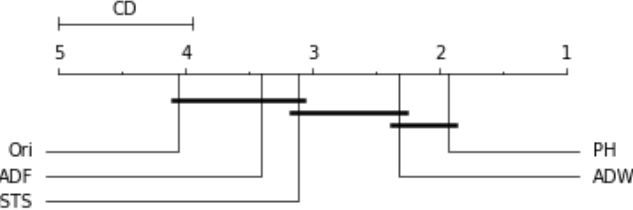
Figure 6. Comparison of the RMSE values obtained by segmentation techniques for Naive predictor according to the Nemenyi test. Groups that are not significantly different ( α = 0.05 and CD = 1.04) are connected.